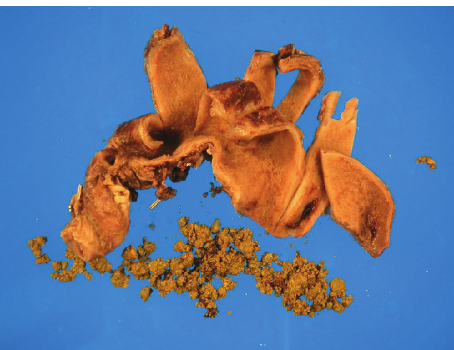
Figure 1: Surgical specimen (gallbladder, with resection clips) showing a large number of greenish-brownish gallstones of various sizes and “crumbly”